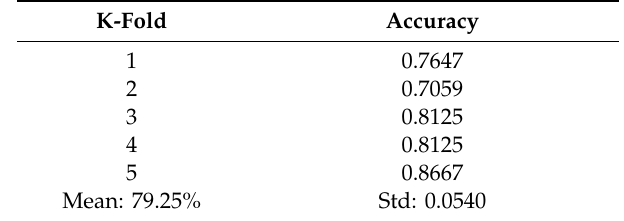
Table 5. Accuracies achieved by performing 5-Fold Cross-Validation on the SVM-Linear model.